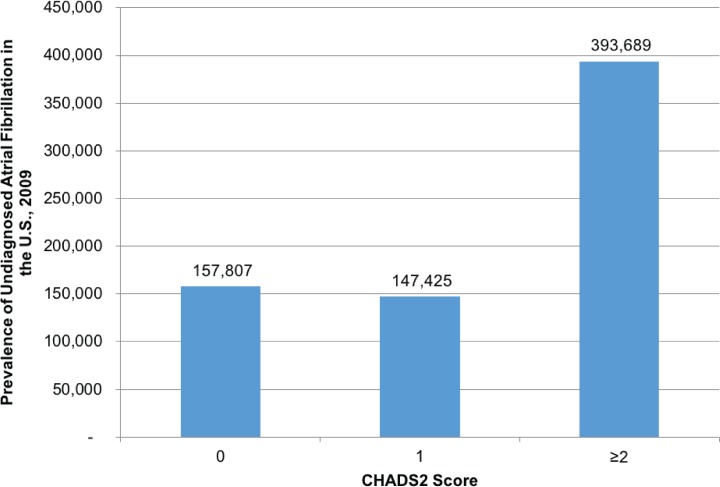
Distribution of CHADS2 scores among patients with undiagnosed atrial fibrillation.